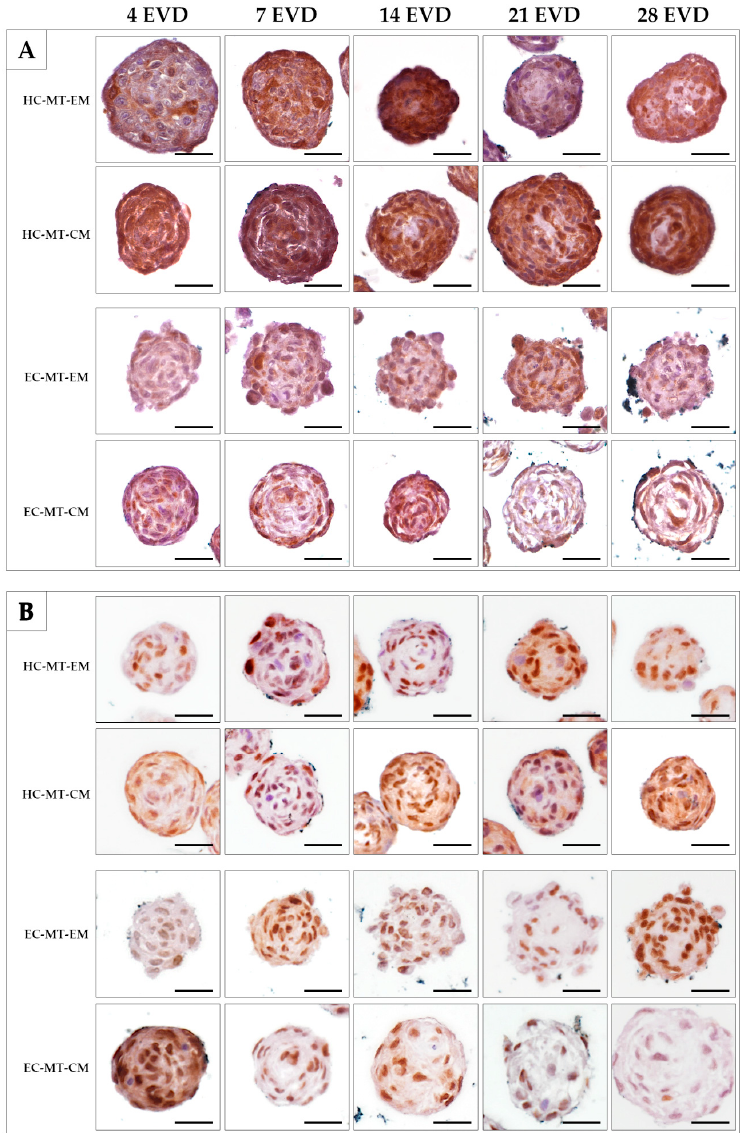
Figure 6. Time course of histochemical analysis of chondrogenic marker S-100 ( A ) and proliferating marker PCNA ( B ) in the HC-MTs and EC-MTs cultured in EM and CM. Note that chondrogenic MTs show an S-100-positive reaction in all experimental conditions, being higher in HC-MTs ( A ). It is possible to observe that MTs are composed of abundant proliferating cells, where, in the case of EC-MTs, differences were observed with the use of CM ( B ). Scale bar = 50 µm.